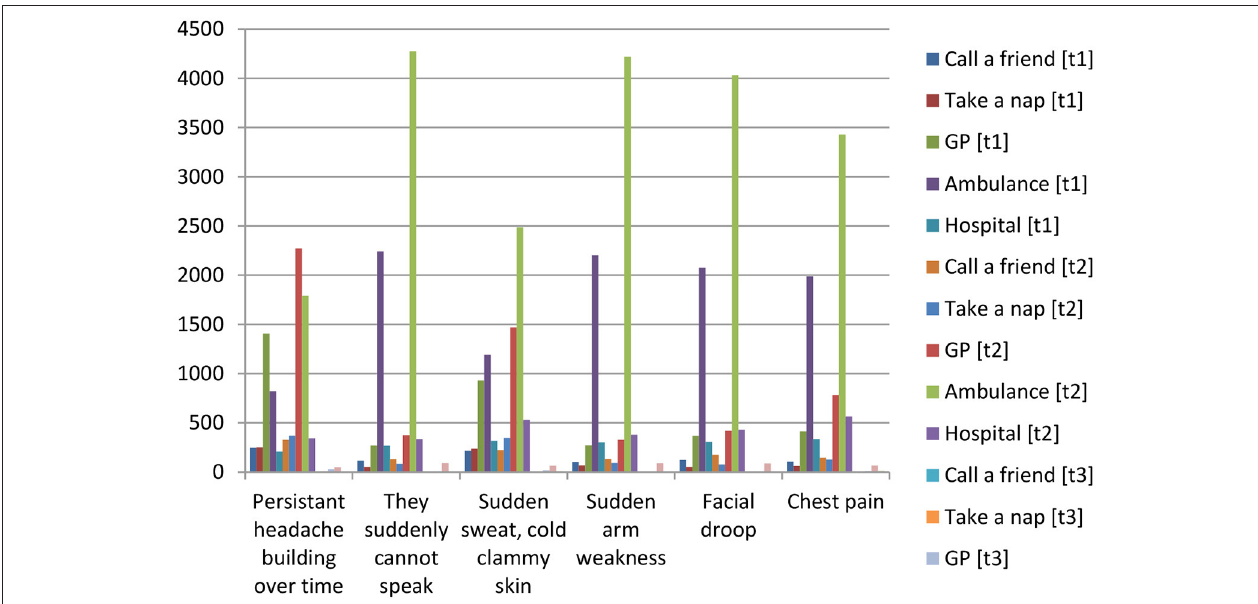
FIGURE 2 | Graph of parents’ answers in regard to the action they would take in case of stroke and non-stroke symptoms across the three assessments (t1, t2, t3).